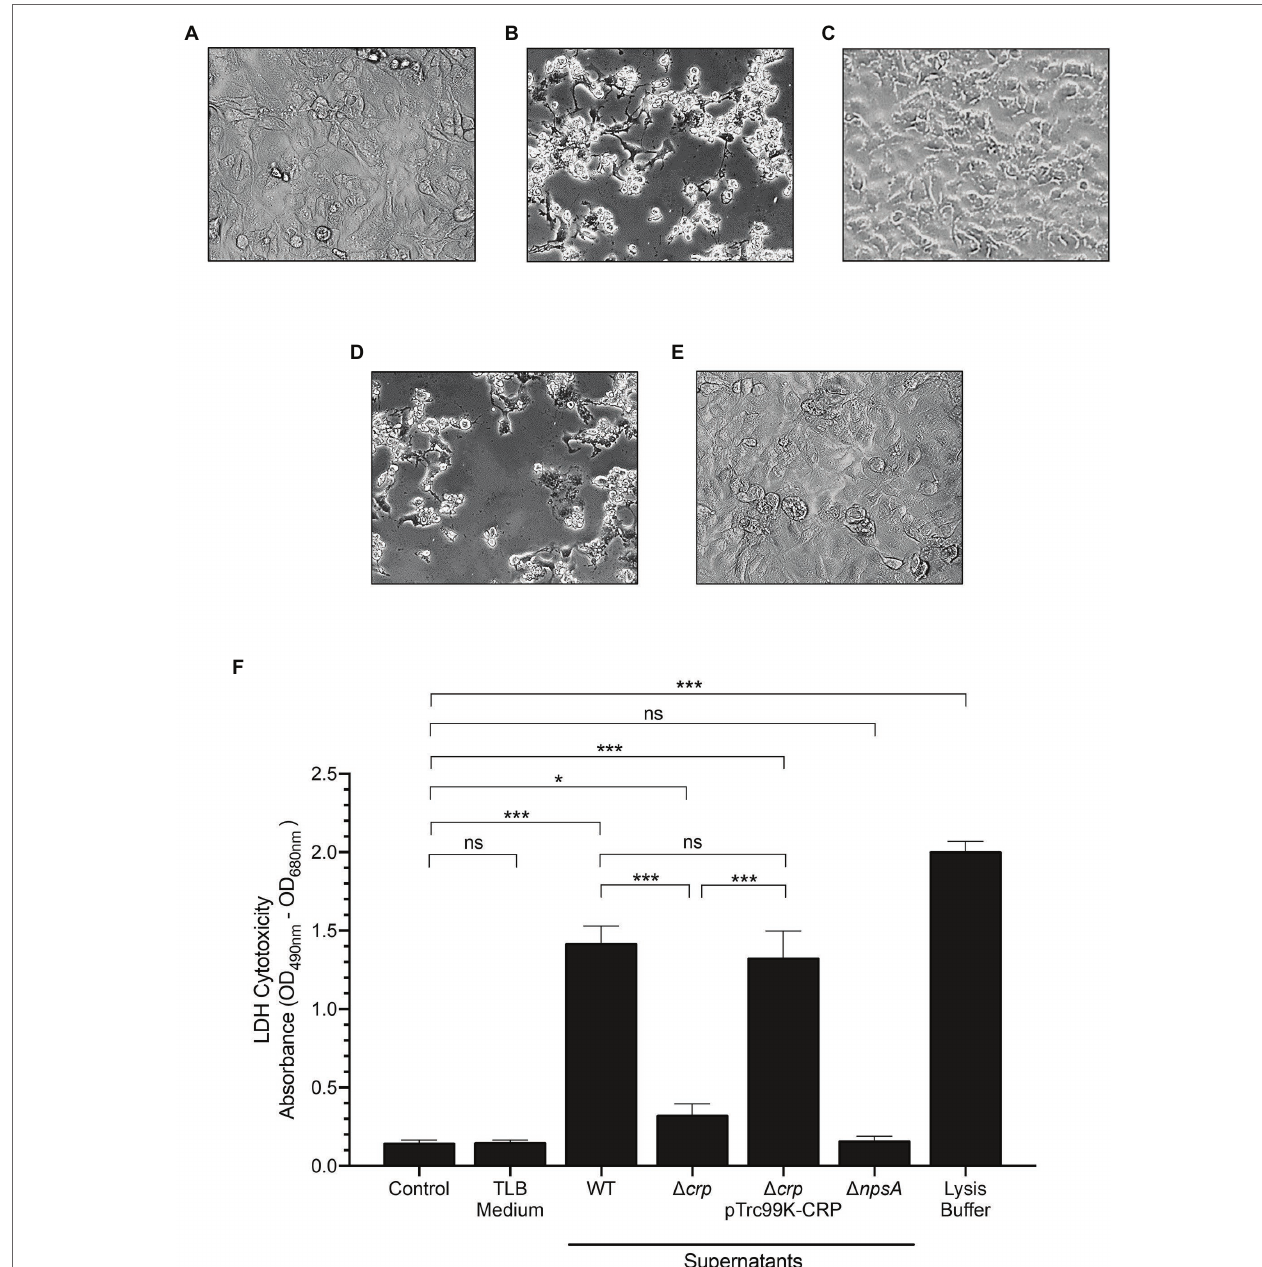
FIGURE 4 | Cytotoxicity of K. oxytoca Δ crp mutant strain. HeLa cell culture inoculated with: (A) TLB medium as control, and (B) wild-type (C) Δ crp (D) Δ crp pTrc99K-CRP, and (E) Δ npsA K. oxytoca supernatants. (F) HeLa cells were treated with TLB medium, and K. oxytoca supernatants (wild-type, Δ crp , Δ crp pTrc99K- CRP, and Δ npsA ) for 48 h. Following treatment, aliquots were obtained for measurement of extracellular LDH. Minimal and maximal measurable LDH release was determined by incubating cells with PBS (control), and lysis buffer, respectively. Statistically significant: * p < 0.05; *** p < 0.001; ns: not significant. All values of p were calculated using one-way ANOVA and Tukey’s comparison